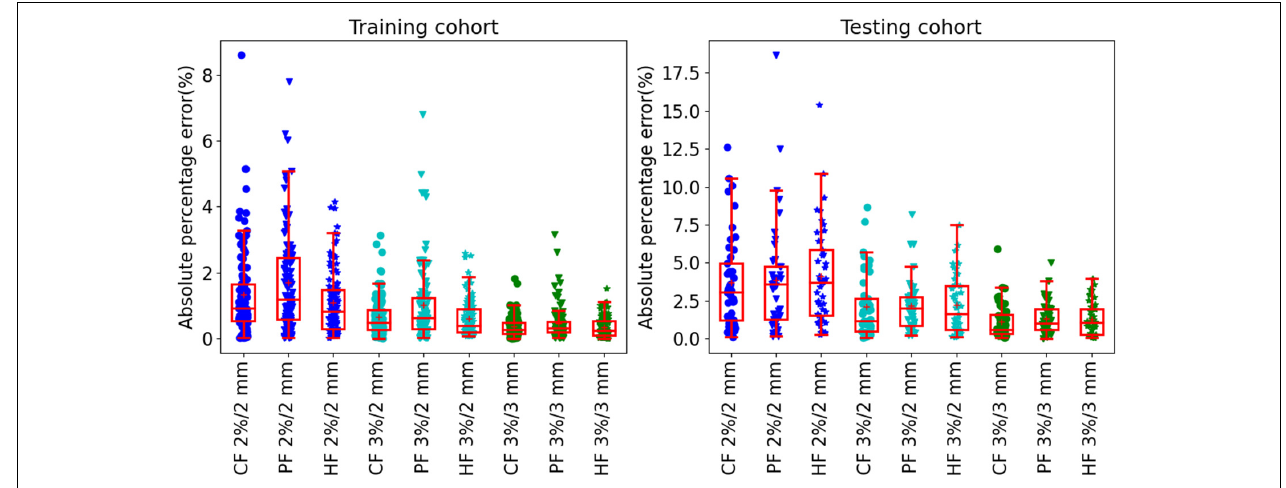
FIGURE 4 | The absolute prediction error by using different feature modalities at gamma criteria of 2%/2 mm, 3%/2 mm, and 3%/3 mm for the training (left figure) and testing (right figure) cohort, respectively. All solid circles, triangles, and pentagrams are the APE values. The red box shows the quartile values of each set of APE data. The red solid line and red plus inside the box are the median and average values, respectively.